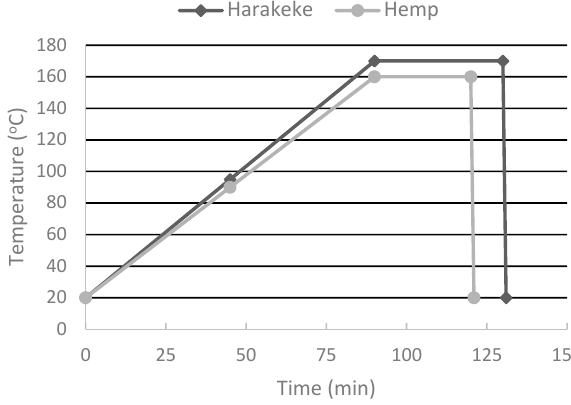
Figure 1. Digestion cycle for hemp and harakeke.